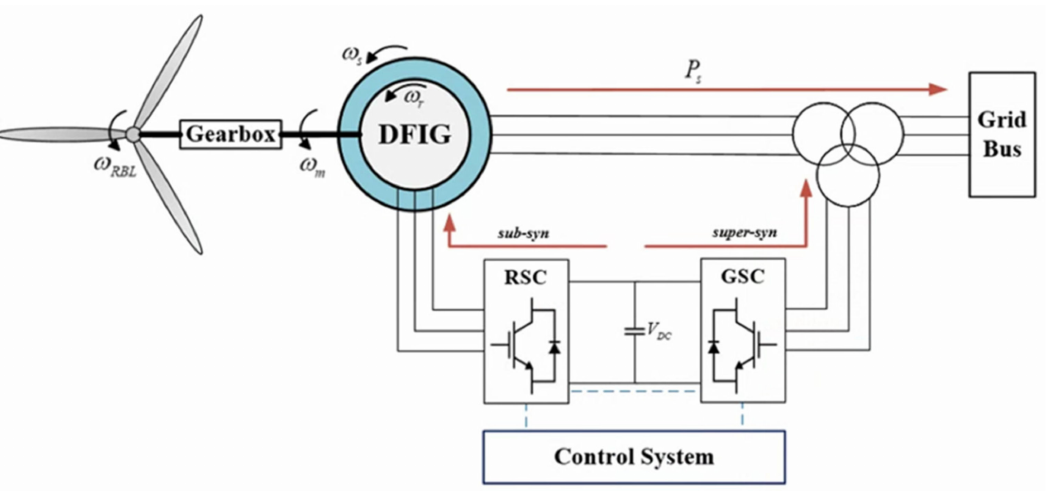
Figure 6. Power-generation